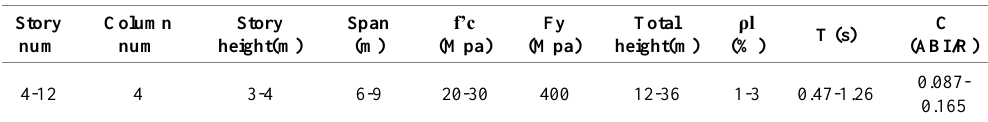
Table 2 . Specimens’ specifications